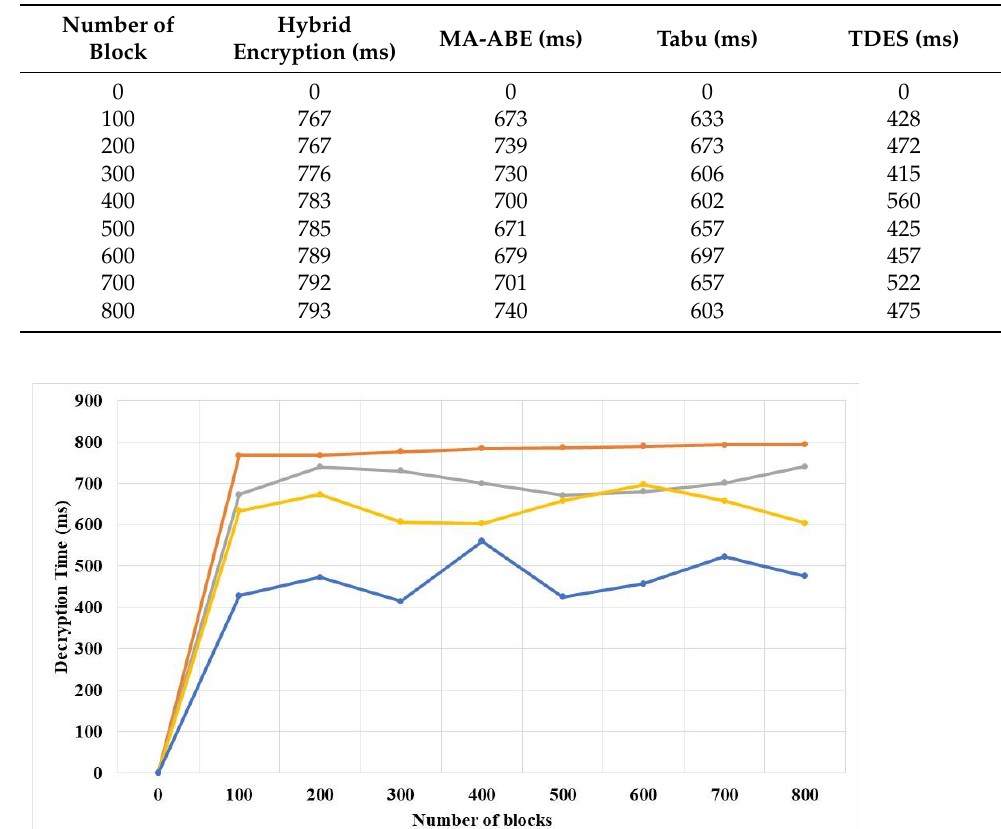
Table 9. Running time of TDES and comparison with existing technique.